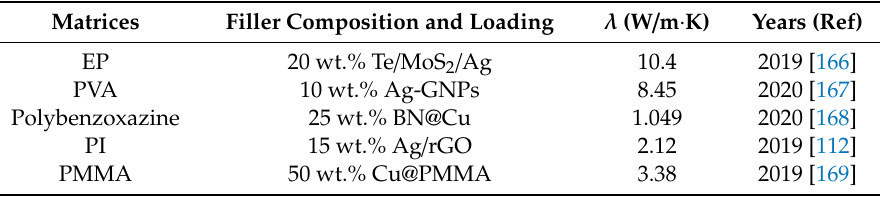
Figure 21. ( a ) Schematic of the fabrication process of the CNTs–graphite film (GF)/Al laminated composites block. ( b ) λ of CNTs–GF/Al and GF/Al composites in the xy and z directions (reproduced with permission from [86]). Table 7. λ of metal fillers/polymer composites.